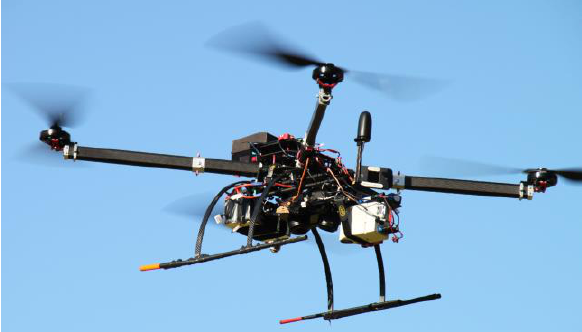
Figure 3 . The drone and the sensor payloads used in the flight